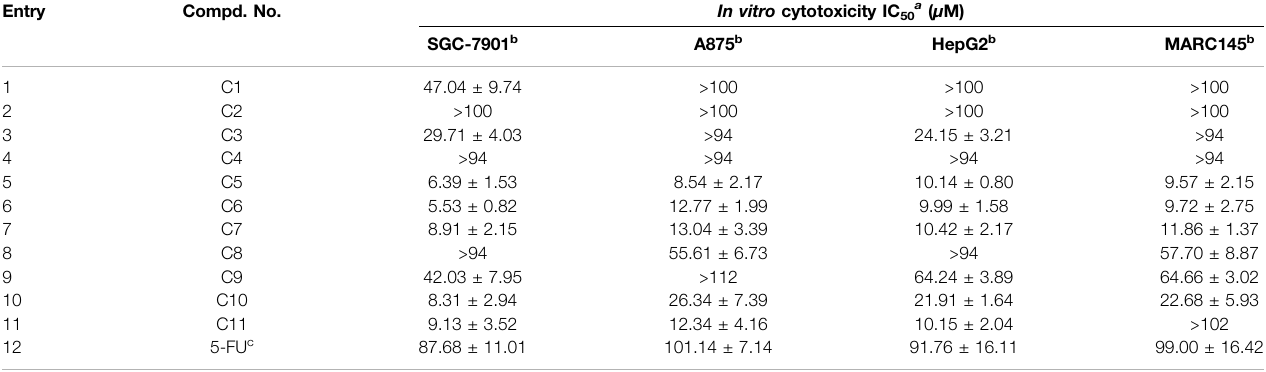
TABLE 3 | In vitro cytotoxic activities of the diarylamine guided amide derivatives C1-11. Entry Compd. No.